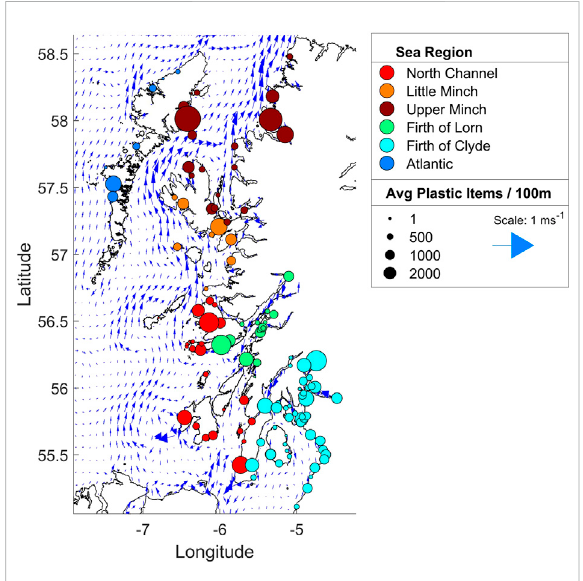
FIGURE 3 Spatial distribution of the average NP/100 m on the west coast of Scotland between 1994 and 2019 (inclusive), at all survey locations ( n = 127), derived from MCS citizen-science data collection. A vector plot of the yearly averaged surface currents (ms − 1 ) are shown across the model